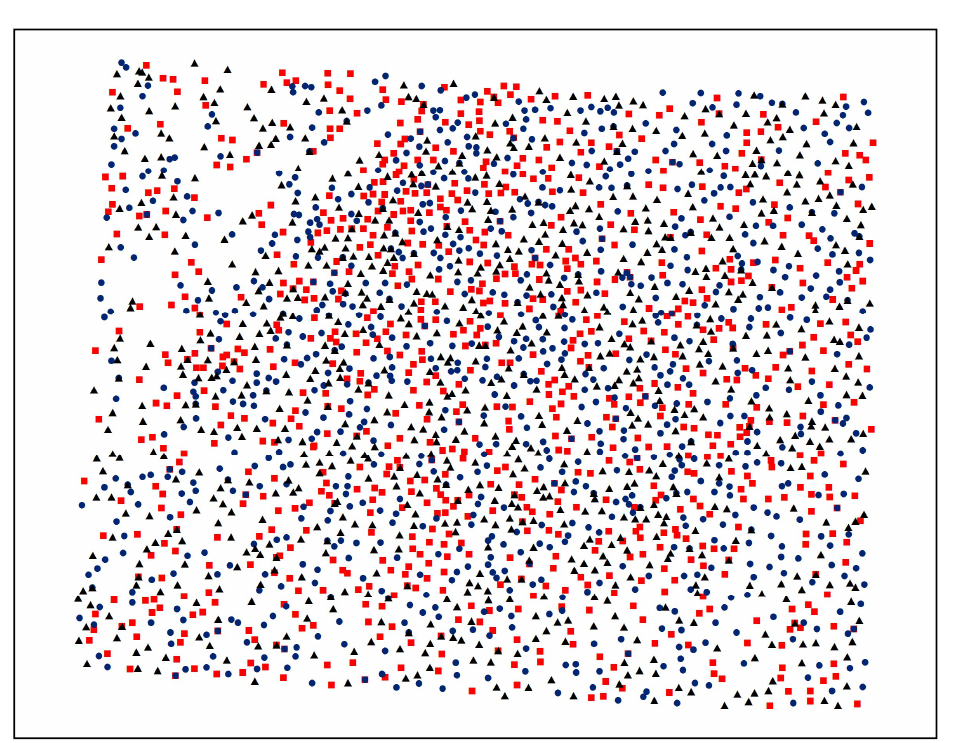
Figure 4. An example of dividing data using three non-repetitive vertex sets.